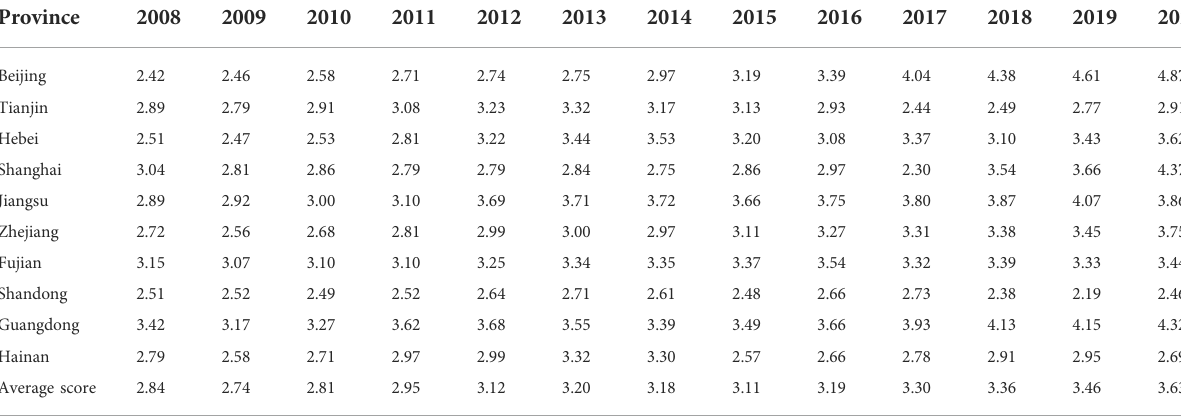
TABLE 2 Scores of Industrial land transformation effect in eastern provinces (2008 – 2020).